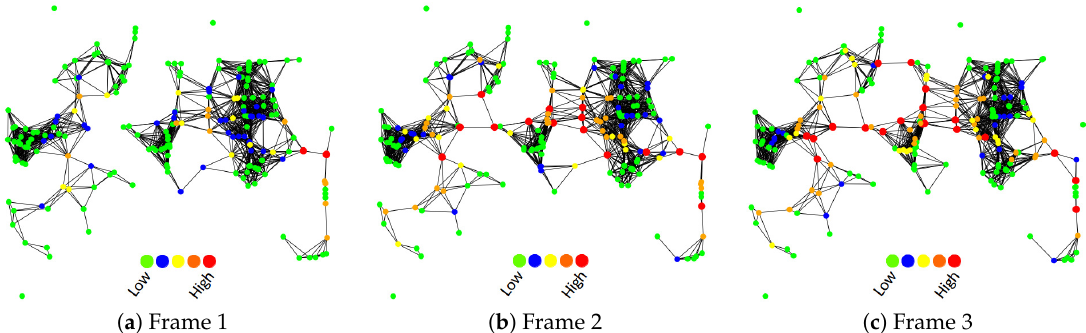
Figure 3. The betweenness centrality score of each node is displayed as a temporal graph, according to the evaluation scenario (traffic density of 150 vehicles/km 2 ).